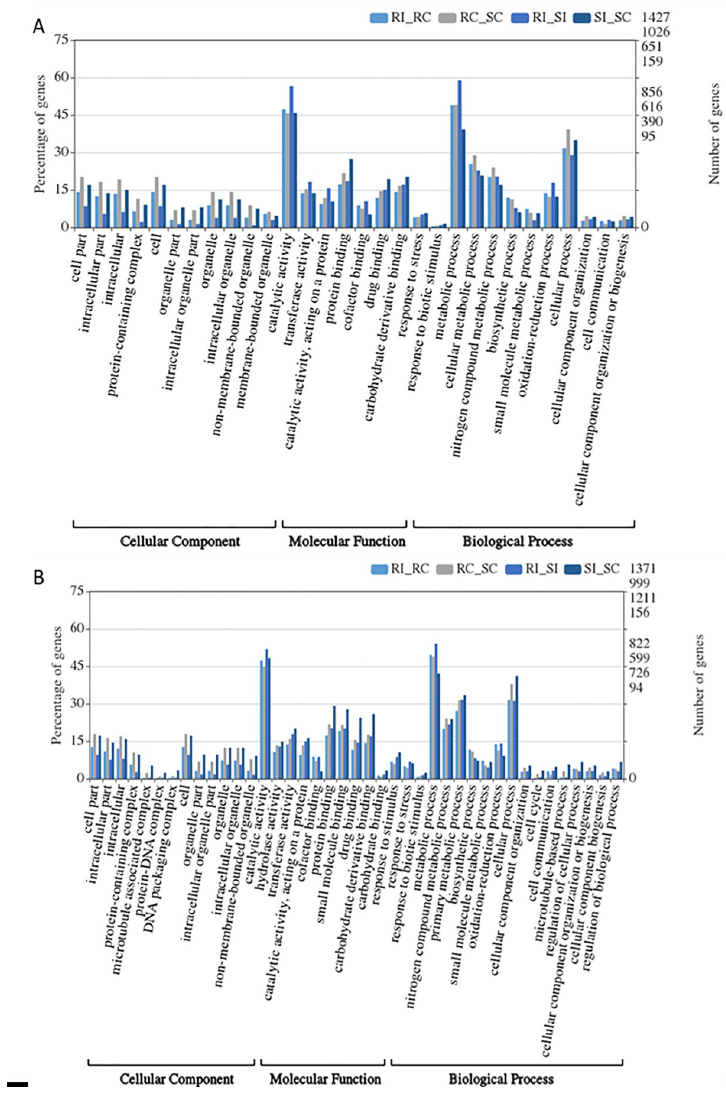
Fig 2. Identified gene ontology terms of DEGs by mapping to (A). A . duranensis genome and (B). A . ipaensis genome. These GO terms are classified into three categories (cellular component, molecular function, and biological processes).